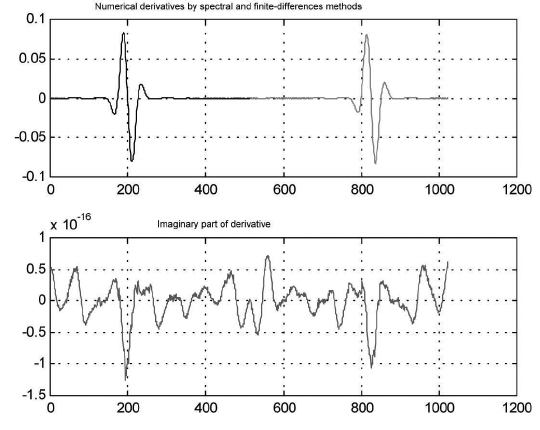
Figure 6. Real and imaginary parts of the first derivative of test signal (3.1) calculated by the spectral method.